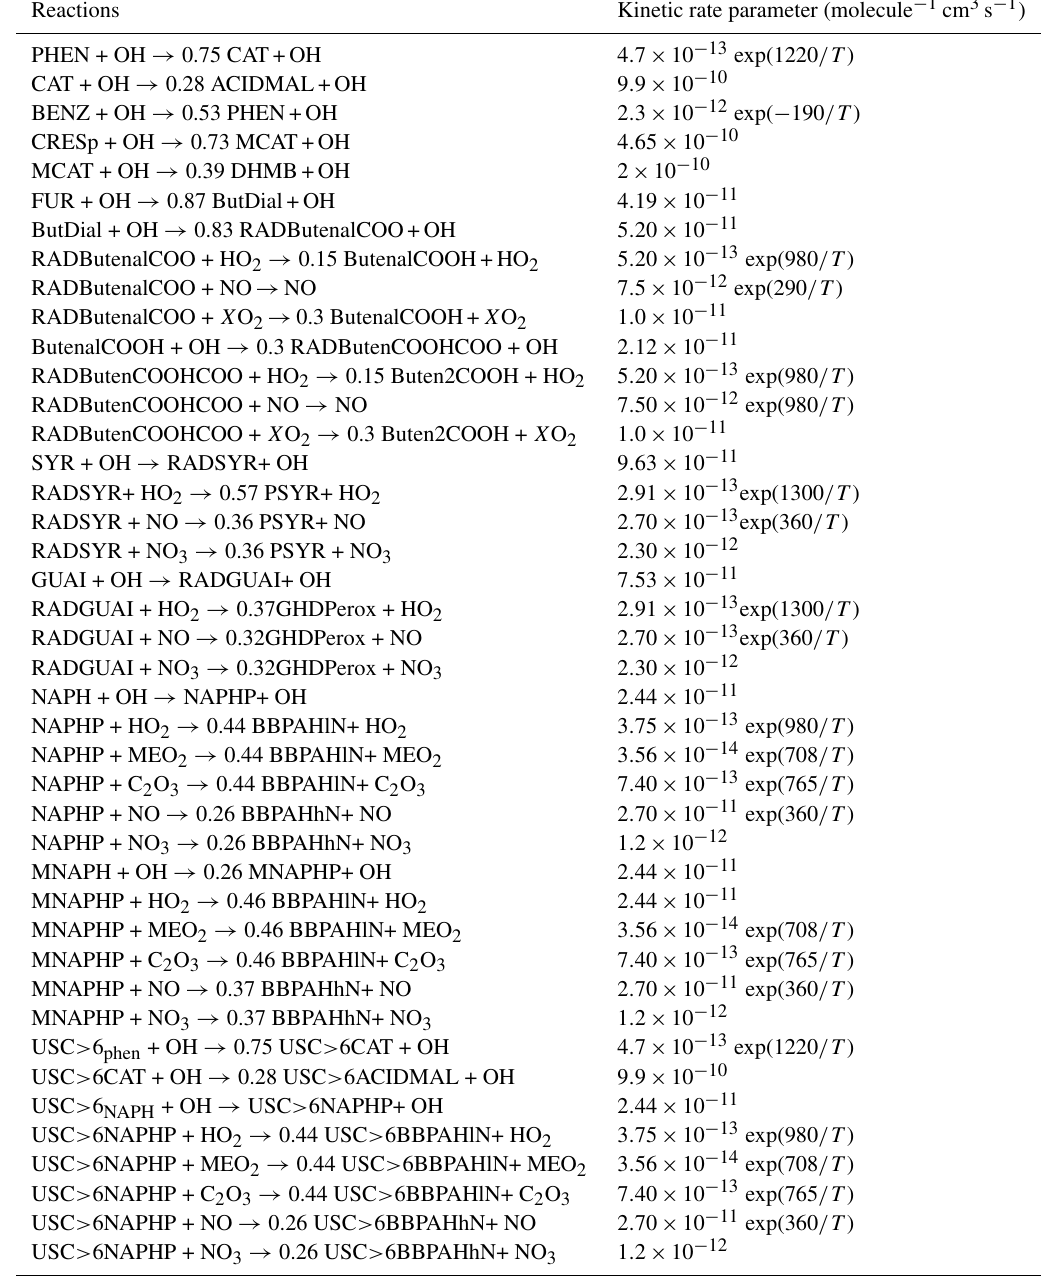
Table B3. Reactions leading to SOA formation added to CB05.